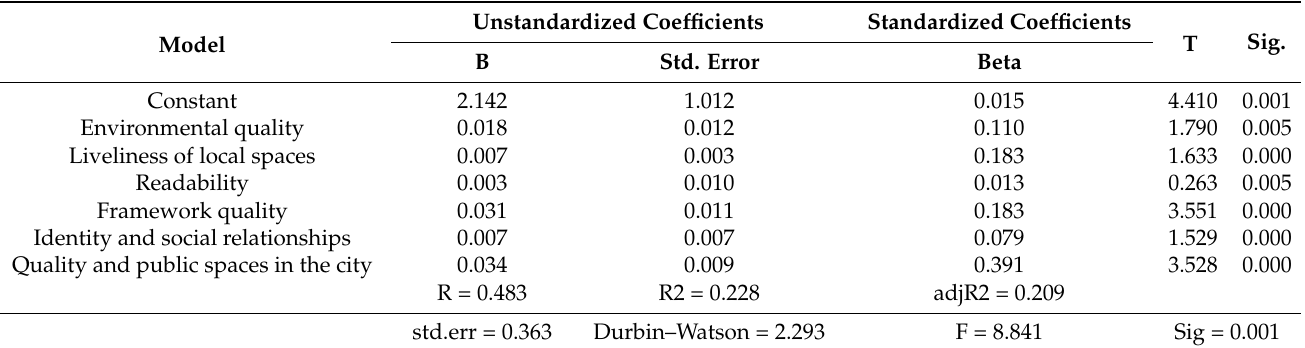
Table 5. Coefficients of the effect of regression model of independent variables on the dependent variable of mental and physical